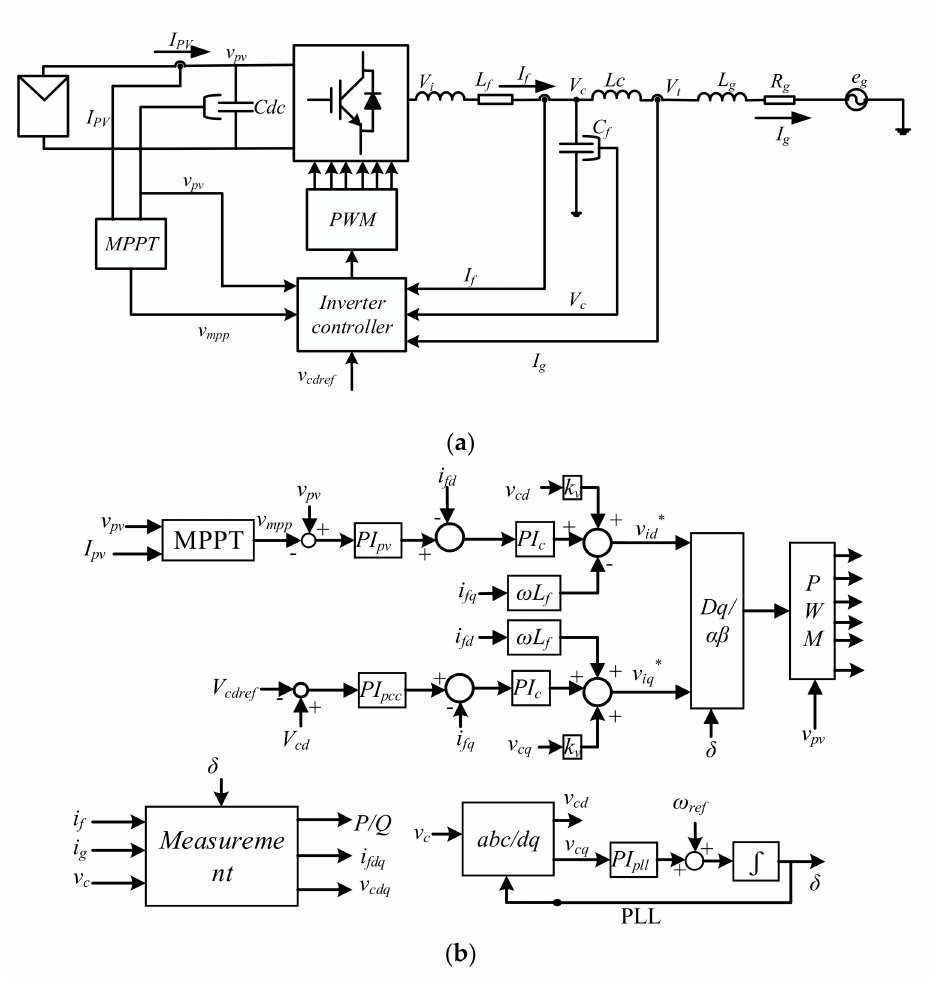
Figure 1. ( a ) Single-line representation of single-stage grid-connected PV inverter and ( b ) control system for grid-connected